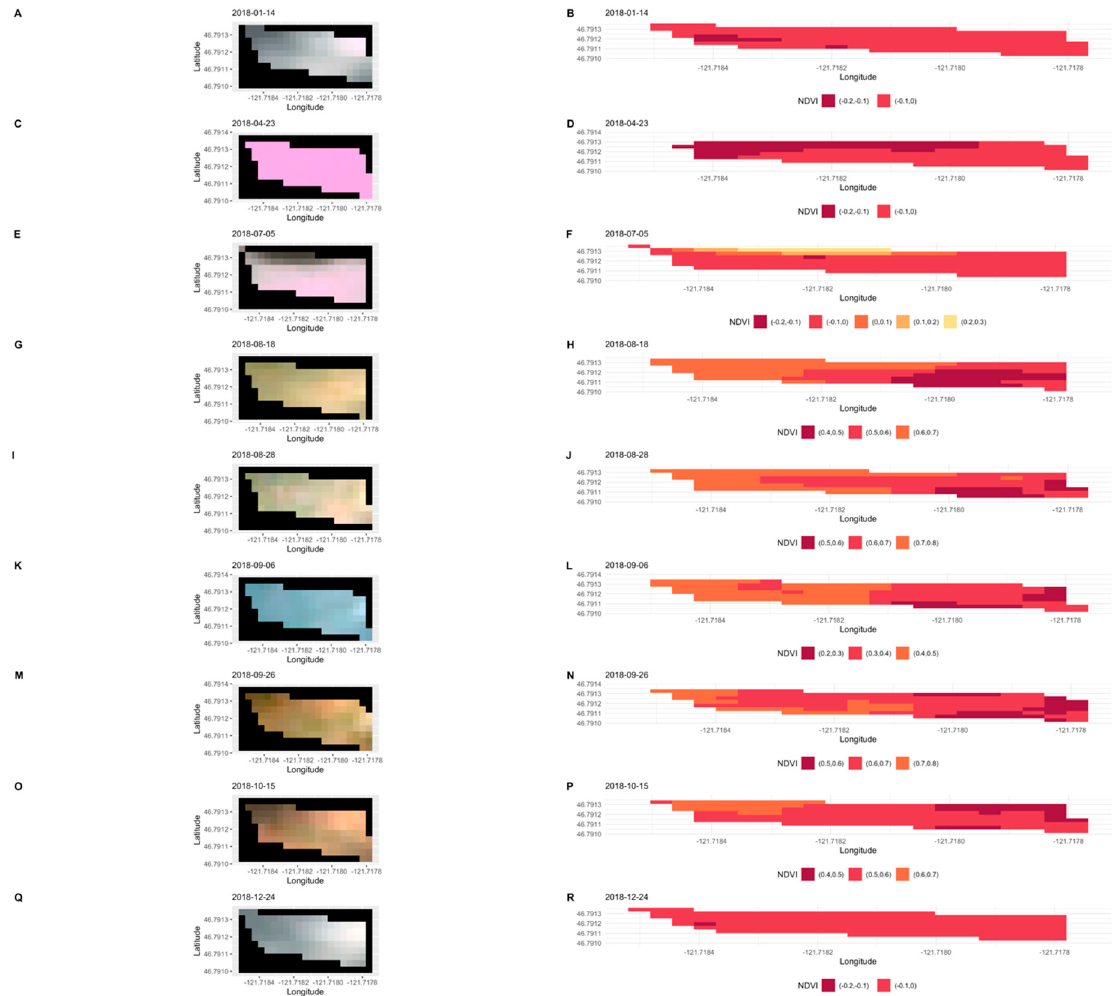
Figure A6. True color composite (red, green, and blue band combined) and corresponding NDVI of Meadow 4 (1779 m) for the year 2018. Column 1 for the panel gives a sense of how the meadow is changing during the whole year; starting from covered with snow ( A , C , E ), then meadow green-up and flowering ( G , I , K ), to senescence ( M , O ), and back to covered with snow ( Q ). Column 2 show the change in seasonality that is captured by NDVI; it shows in months till July NDVI remains below 0.2–0.3 ( B , D , F ), then a sharp increase in NDVI ( H , J , L ), and finally back to low levels of NDVI confirming snow ( N , P , R ).